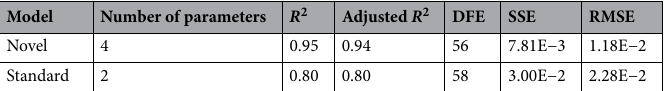
time-of-flight distribution, when experimental estimates are integrated over the TOF. Thus, under the validity of Eq. (2), we can include those effects as follows 28 :